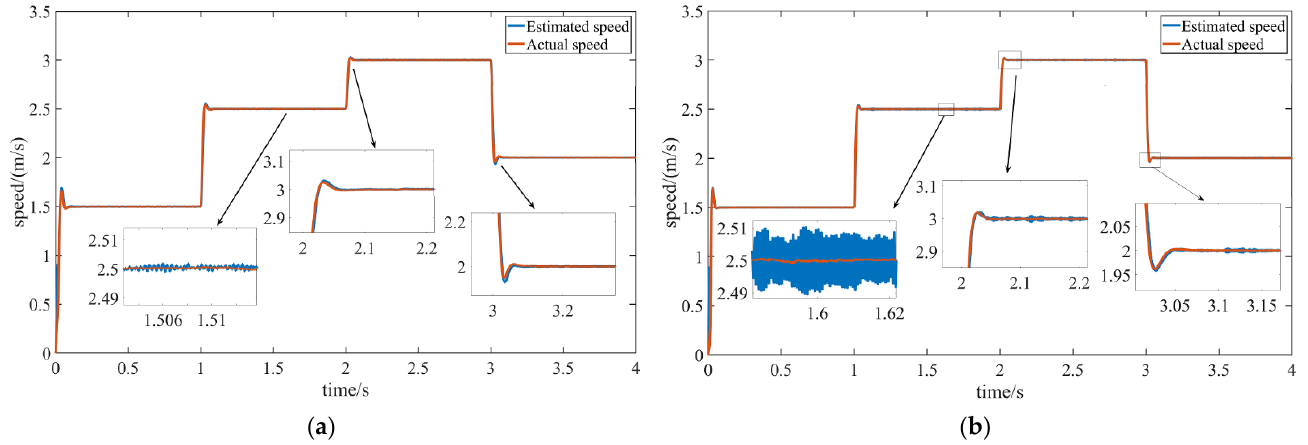
Figure 12. Comparison of the tracking performance of two systems: ( a ) ST-SMO system; ( b ) tradi- tional SMO system.